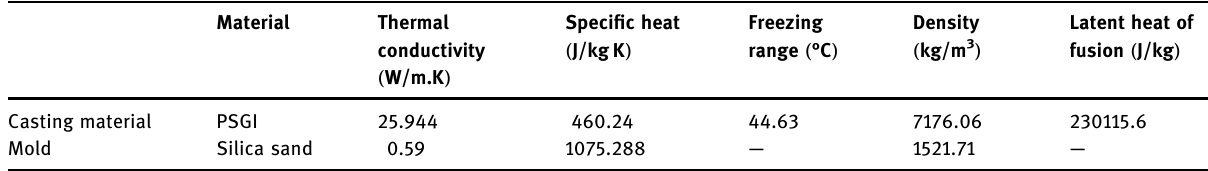
Table 1: Thermo - physical properties of the casting material and the mold [ 26 ]